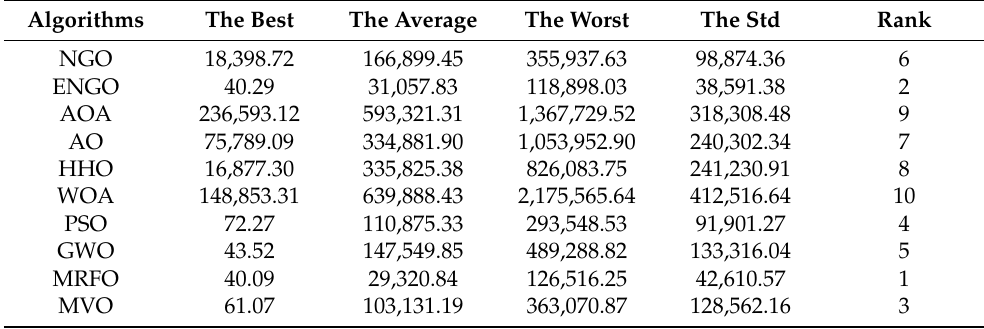
Table 8. Results of the different algorithms in solving the four stage gearbox design problem. Algorithms